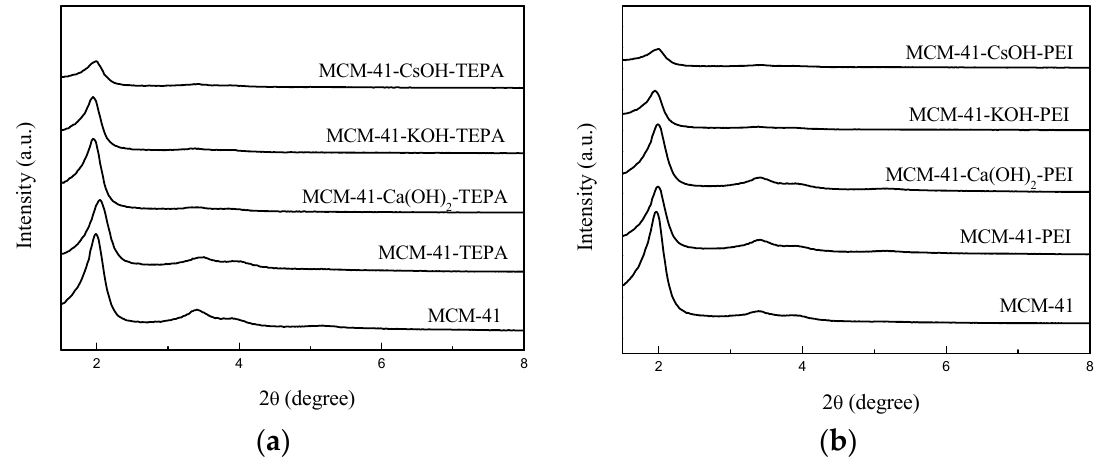
Figure 1. XRD patterns of MCM ‐ 41 modified by ( a ) tetraethylenepentamine (TEPA) ( b ) polyethylenimine (PEI) and various alkali components. Table 1. Pore structure parameters of various adsorbents.